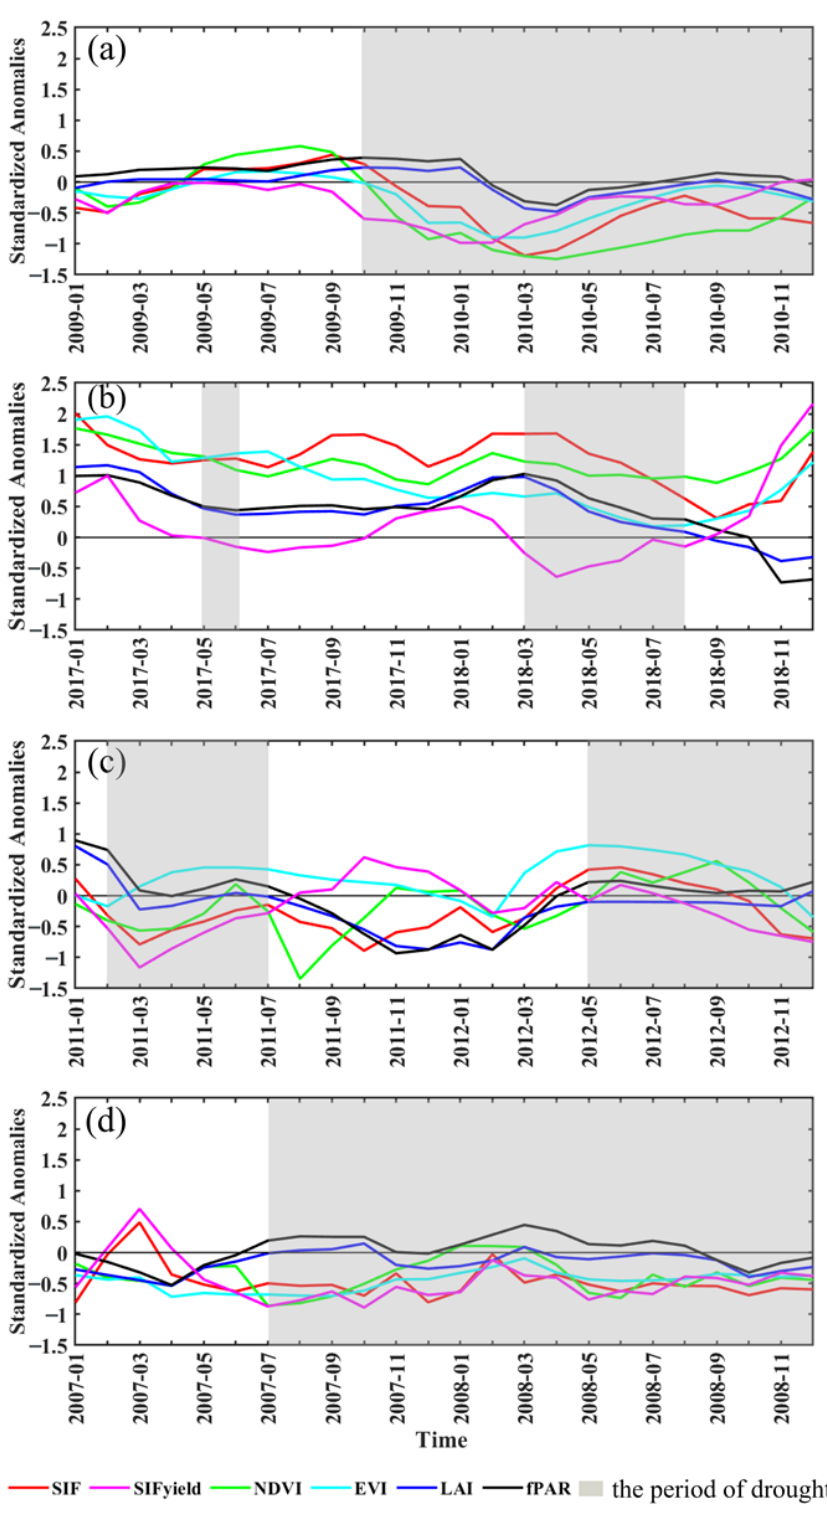
Figure 3. Variation trends of SIF, SIFyield, NDVI, EVI, LAI, and fPAR standardized anomalies during drought periods in four provinces. ( a ) Yunnan province; ( b ) Fujian province; ( c ) Shaanxi province; and ( d ) Heilongjiang